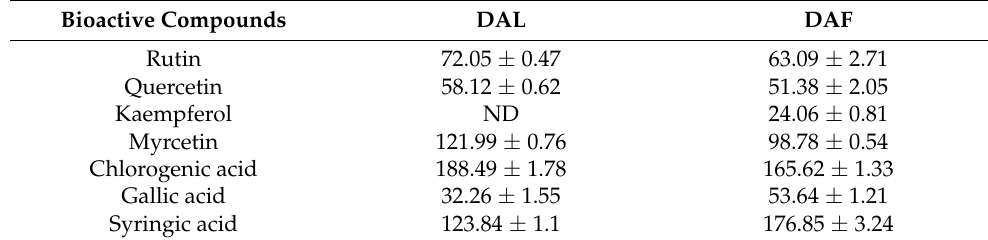
Table 3. The contents (mg/100 g) of flavonoids and phenolic acids in the methanol extract of different parts of D. angustifolia .